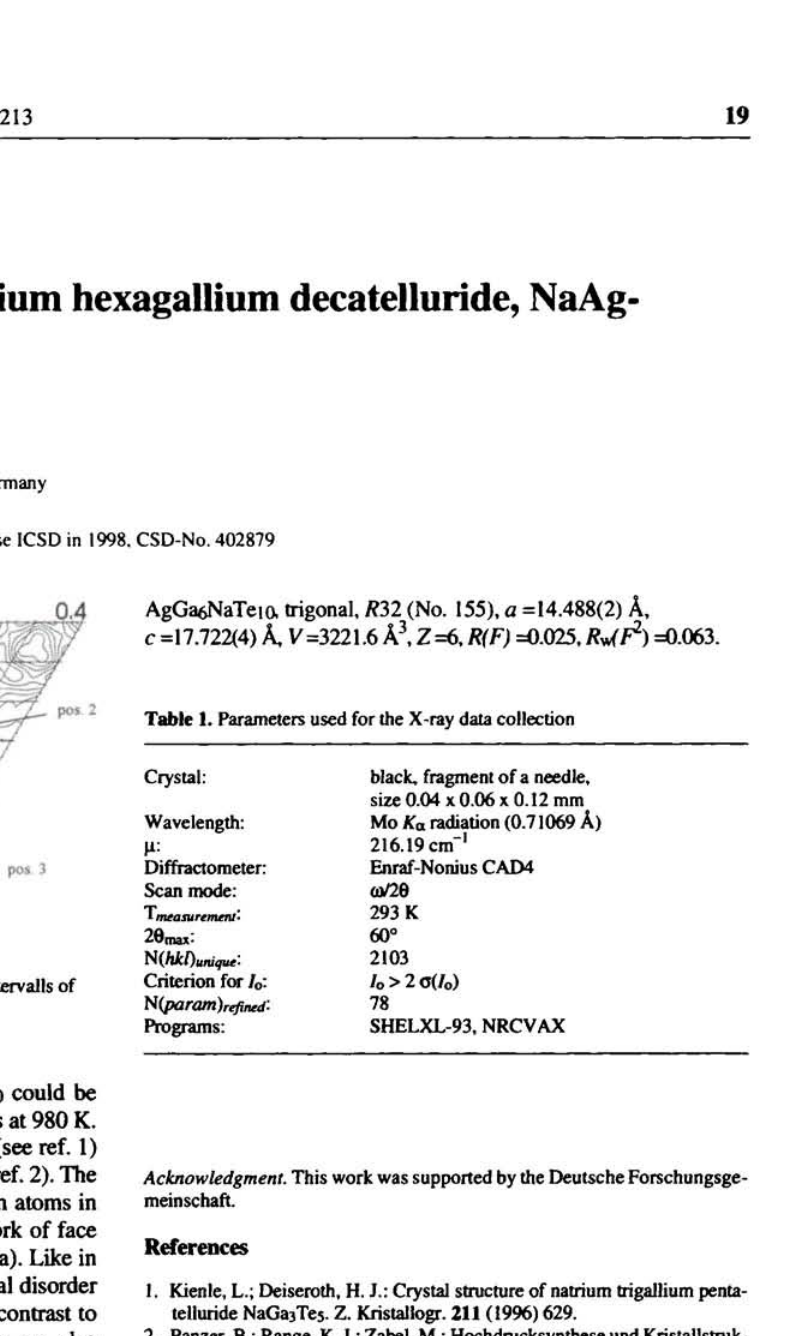
Table 1. Parameters used for the X-ray data collection Crystal: